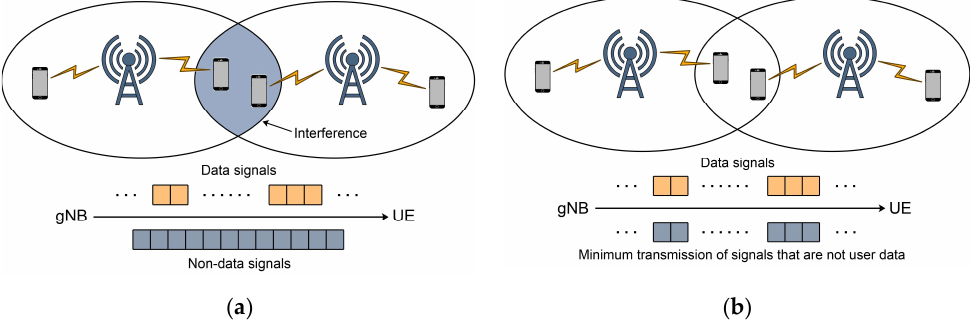
Figure 14. Activity of the radio network based on ( a ) always-on signals, ( b ) ultra-lean design.